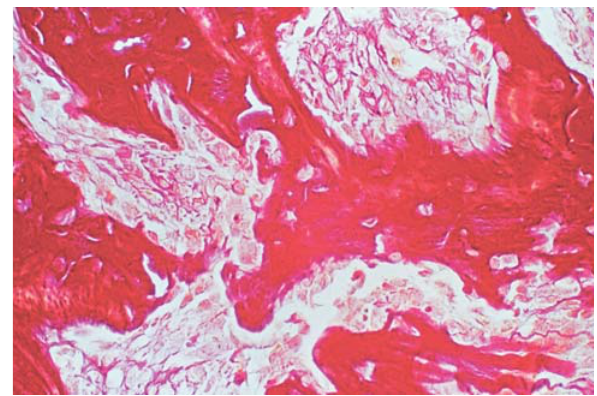
FIGURE 2- 60 days - control group. Woven bone surrounded by osteoblasts (P.S., original magnification,